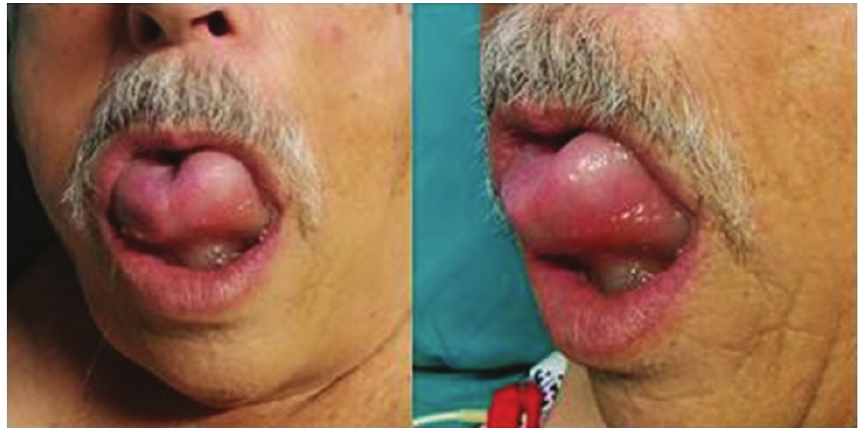
Figure 1: Oropharyngeal edema involving the tongue.